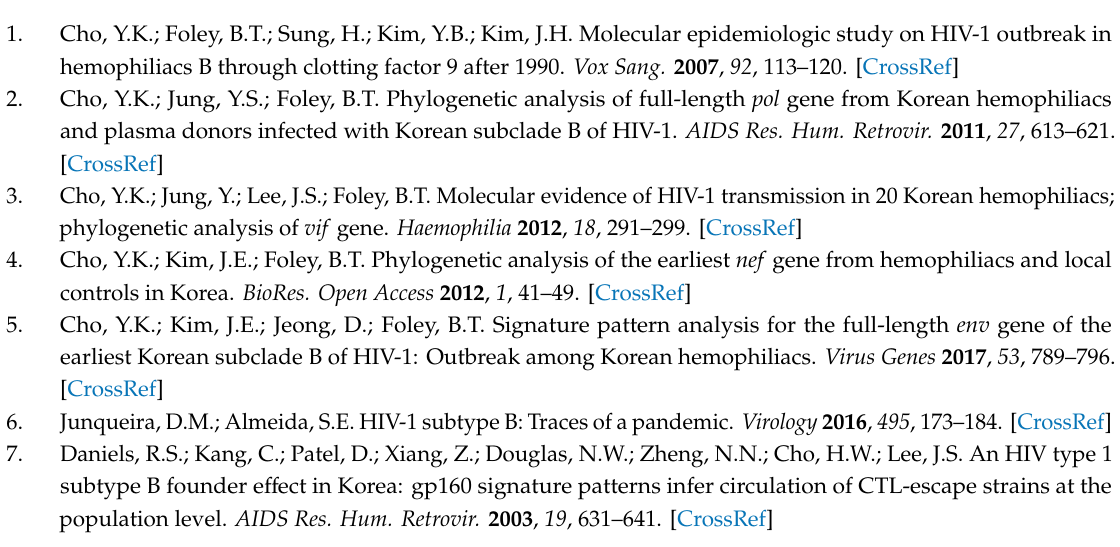
Figure S1: Alignment of 14 signature pattern nucleotides in the 94 patients infected with the Korean subclade of HIV-1 subtype